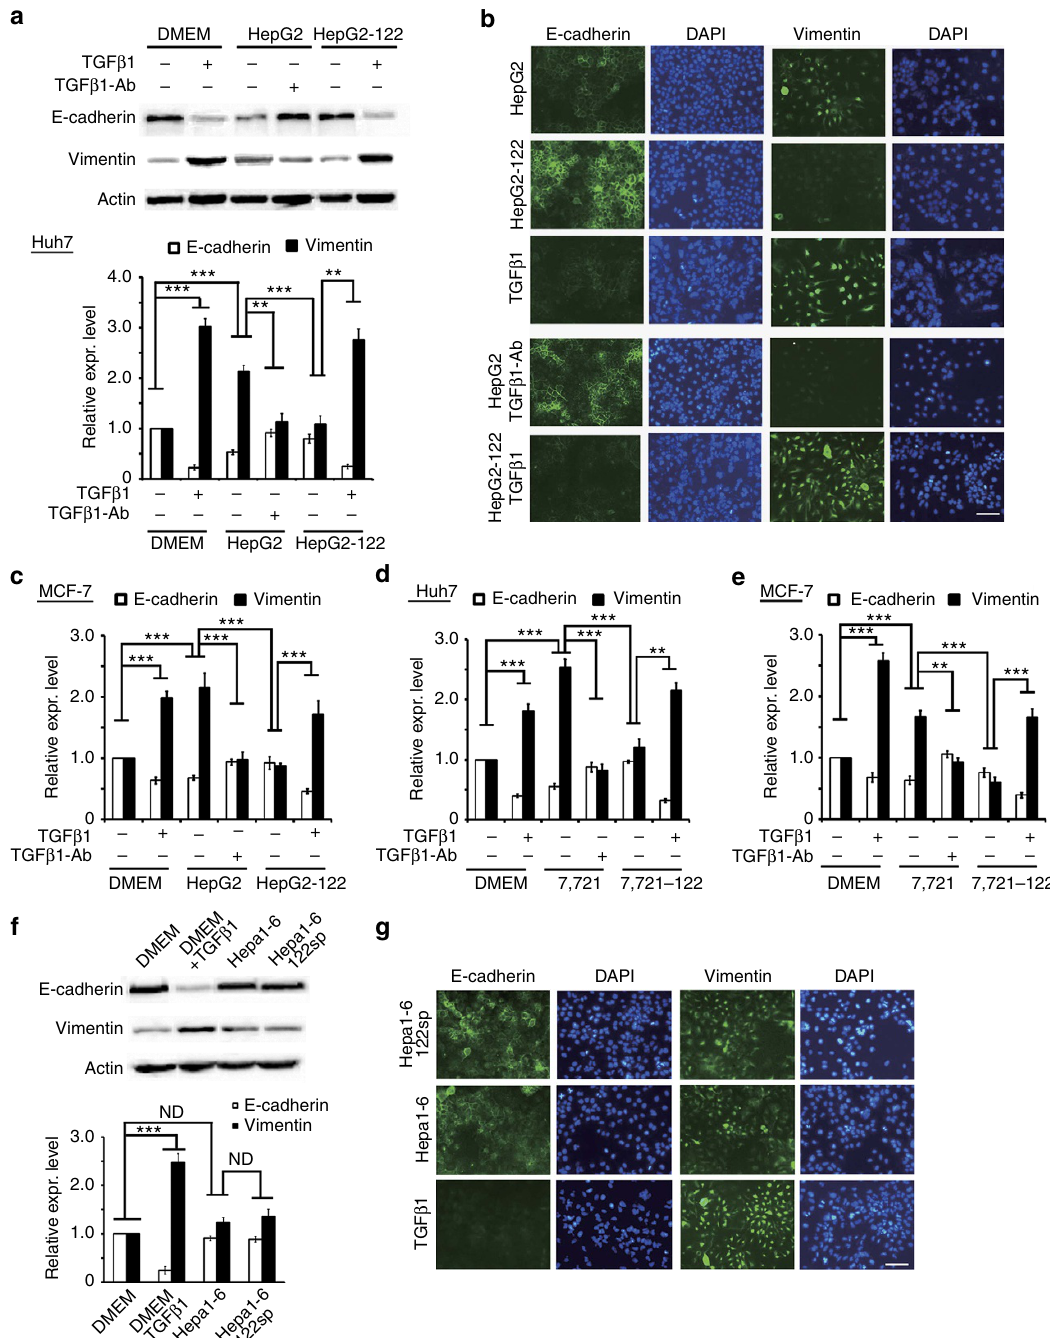
Figure 4 | Differential targeting of TGF b 1/TGF b R1 is the underlying reason for the distinct impact of miR-122 on EMT in human or mouse cells. ( a ) Western blot analysis of E-cadherin and vimentin levels in Huh7 treated as indicated. HepG2 and HepG2-122 stands for the supernatant of HepG2 and HepG2-122 cells, respectively. Quantitative analysis is shown on the right. Three independent repeats are performed in each experiment. ( b ) E-cadherin and vimentin were used as markers of EMT in Huh7 cells treated as indicated. 4,6-Diamidino-2-phenylindole (DAPI) staining was used to detect nuclei. Scale bar, 50 m m. ( c ) Quantitative analysis of E-cadherin and vimentin levels in MCF-7 treated as indicated. HepG2 and HepG2-122 stands for the supernatant of HepG2 and HepG2-122 cells by western blot, respectively. Three independent repeats are performed in each experiment. ( d ) Quantitative analysis of E-cadherin and vimentin levels in Huh7 treated as indicated. 7721 and 7721-122 stands for the supernatant of SMC-7721 and SMC-7721-122 cells by western blot, respectively. Three independent repeats are performed in each experiment. ( e ) Quantitative analysis of E-cadherin and vimentin levels in MCF-7 treated as indicated. 7721 and 7721-122 stands for the supernatant of SMC-7721 and SMC-7721-122 cells by western blot, respectively. Three independent repeats are performed in each experiment. ( f ) Western blot analysis of E-cadherin and vimentin levels in Huh7 treated as indicated. Hepa1-6 and Hepa1-6-122sp stands for the supernatant of Hepa1-6 and Hepa1-6-122sp cells, respectively. Three independent repeats are performed in each experiment. ( g ) E-cadherin and vimentin were used as markers of EMT in Huh7 cells treated as indicated. DAPI staining was used to detect nuclei. Scale bar, 50 m m. Error bars, ± s.d. ** P o 0.01; *** P o 0.001 by two-sided Student’s t